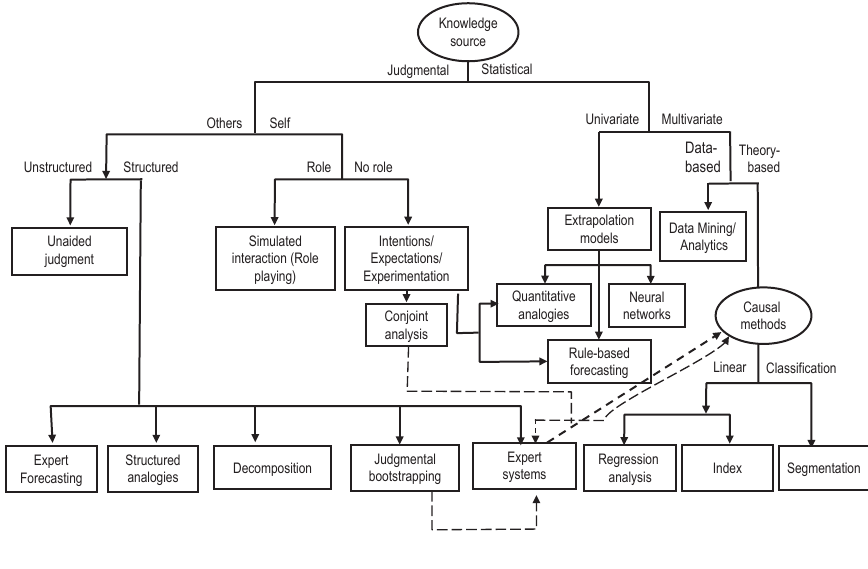
Fig. 1 – Methodology Tree of Forecasting. Source: Armstrong & Green,